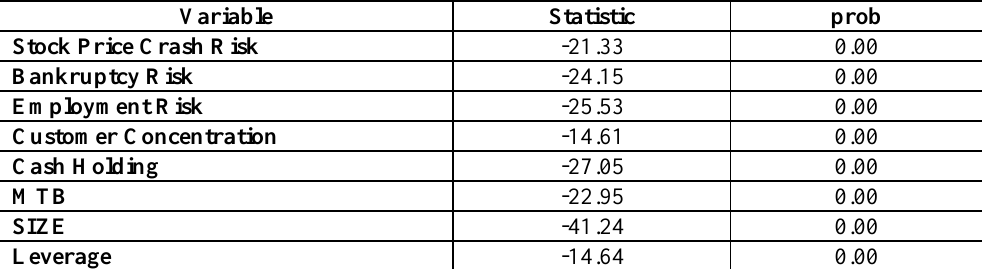
Table 4. The reliability of the research variables